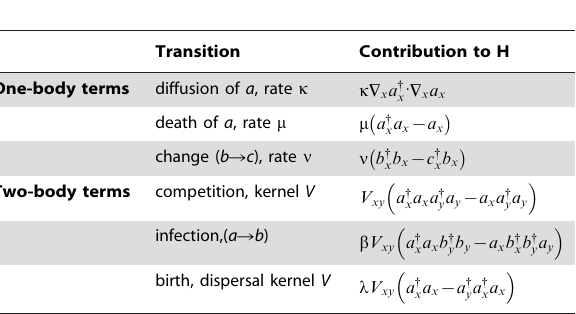
Table 1. A recipe-book for constructing Hamiltonians from transition